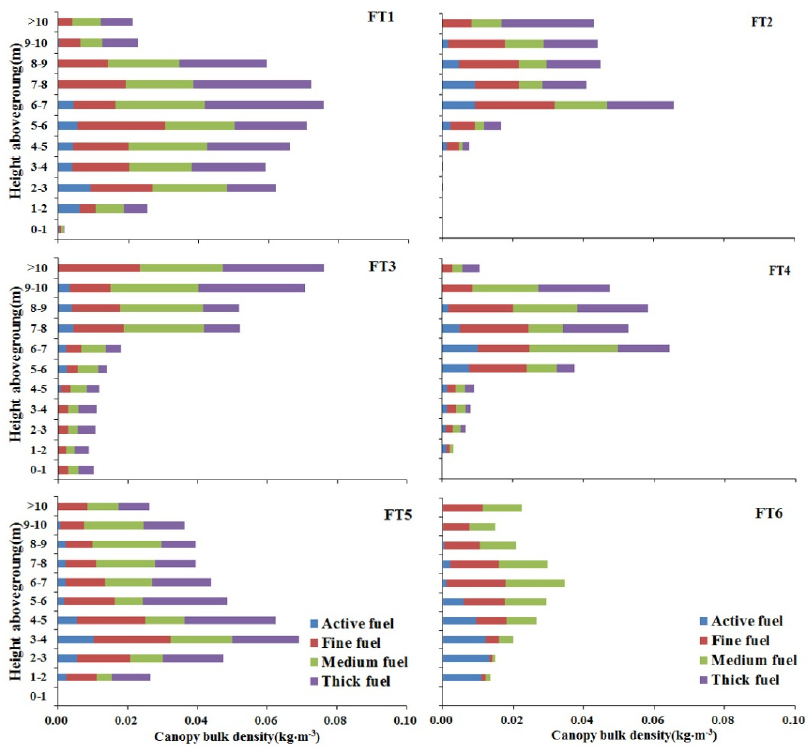
Figure 3. A vertical profile of the aboveground canopy bulk density of four fuel classes in six forest types.